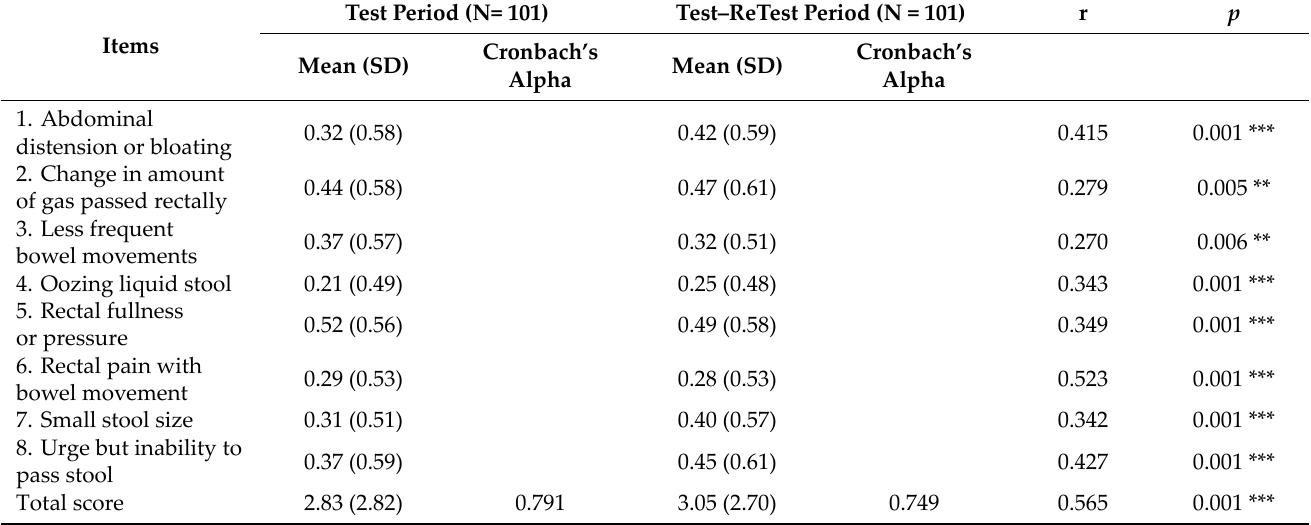
Table 3. The reliability and test‑reliability of CAS‑TC.